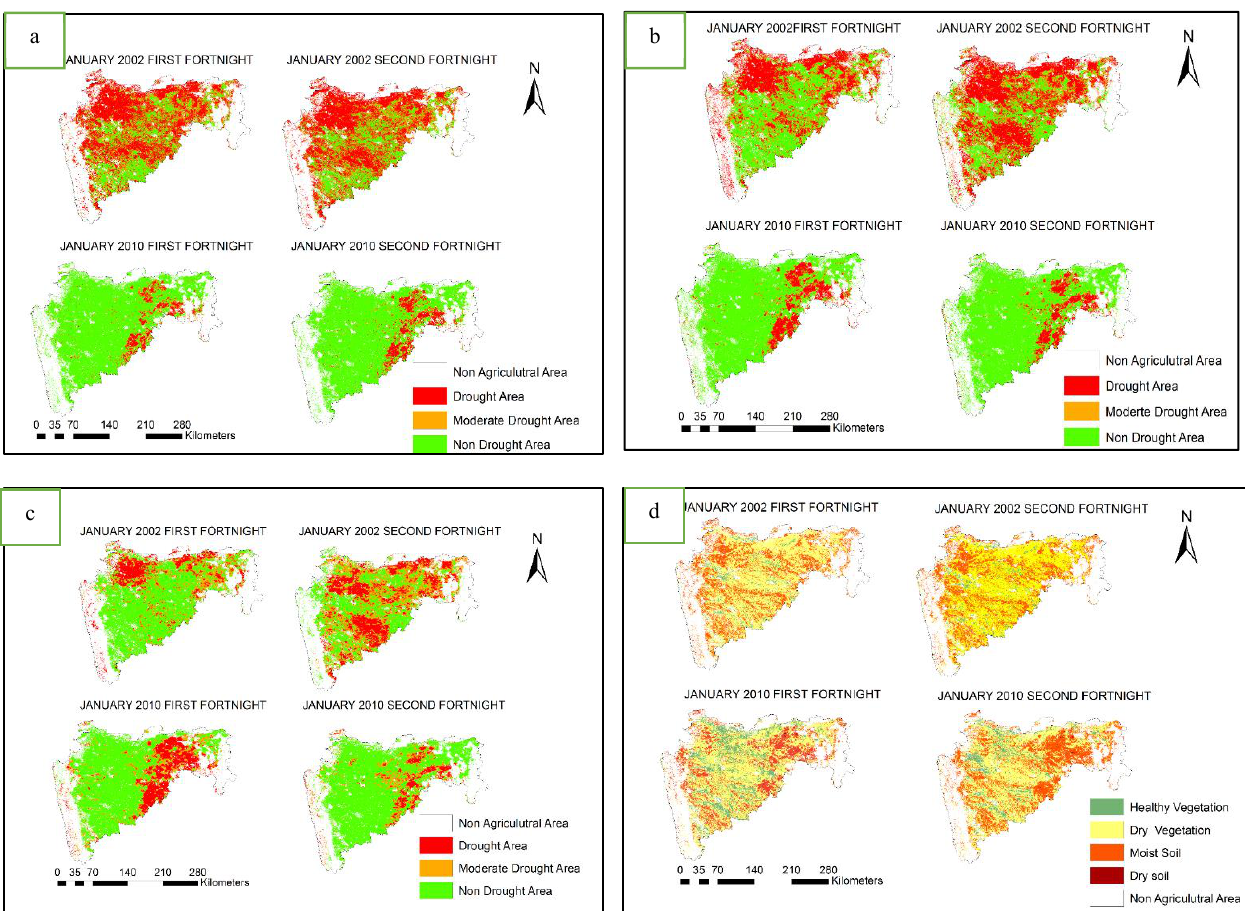
Figure 14(a).VCI maps for the year 2002 and 2010 (b)TCI maps for the year 2002 and 2010 (c)VHI maps for the year 2002 and 2010 (d) SASI maps for the year 2002 and